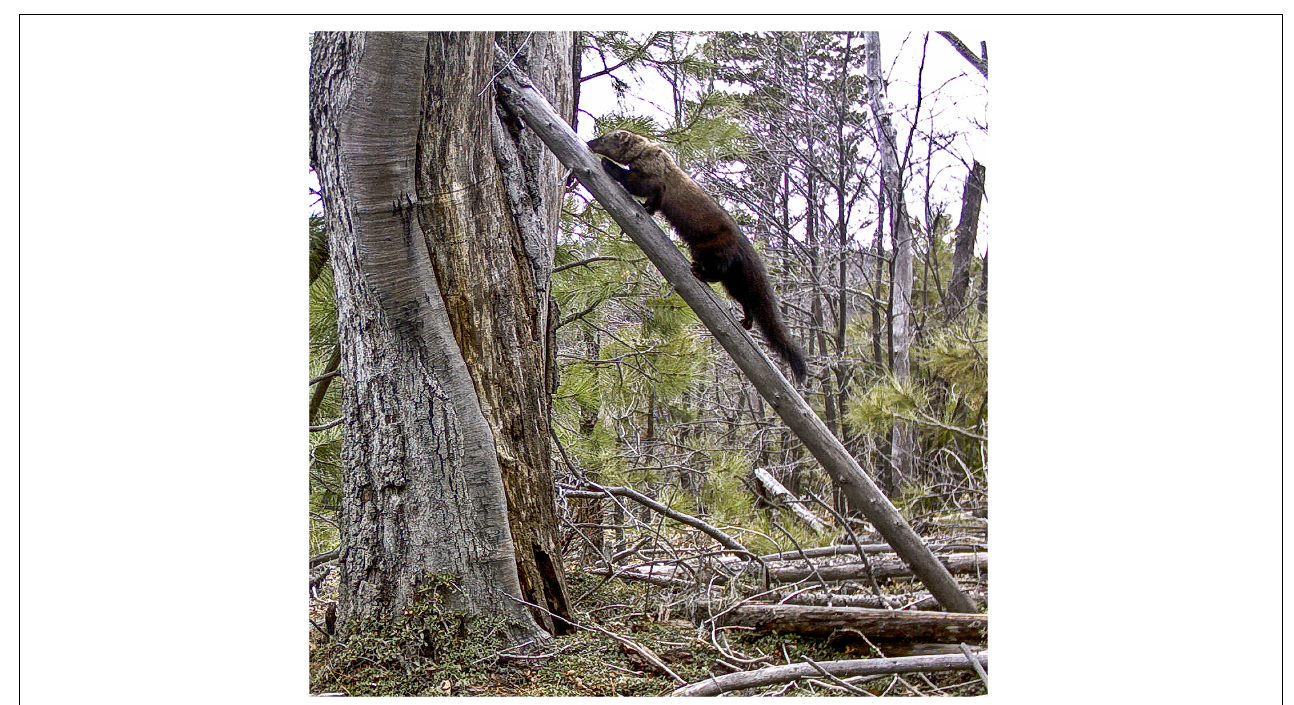
FIGURE 1 | A female fisher ( Pekania pennanti ) wearing a transmitter collar and climbing a log to her den tree, where she has a litter of kits in a cavity. This fisher is a member of a reintroduced population established to investigate the use by fishers of industrial timberlands in northern California (Photo Credit: Fisher Reintroduction in Northern Sierras